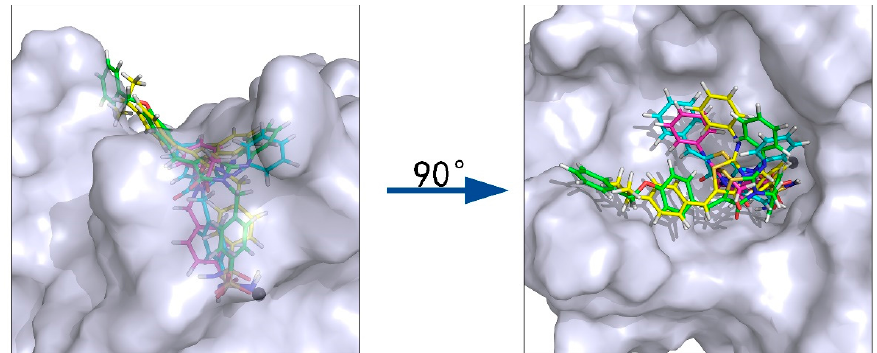
Figure 4. Compounds superposed in CA IX active site: compound ( 2 ) (pink), compound ( 3 ) (turquoise), compound ( 12 ) (green), compound ( 13 )